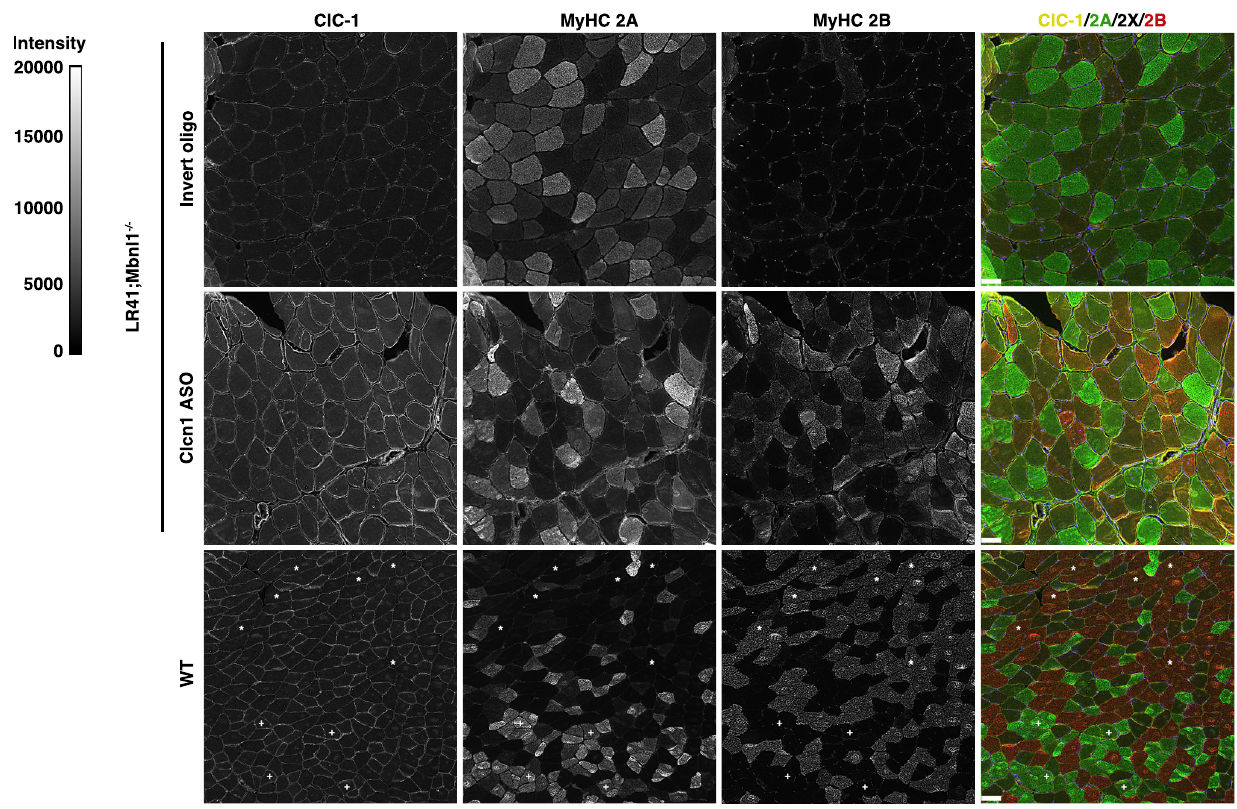
Fig. 4 | Localization of ClC-1 protein. We used antibodies targeting CLC-1, MyHC 2A, and MyHC 2B proteins to label TA muscles of LR41; Mbnl1 − / − treated with Clcn1 ASO or invert oligo for 16 days and untreated WT controls ( N =4 each group). Representativeimagesof eachareshown.Fluorescence intensityis0 – 20,000gray